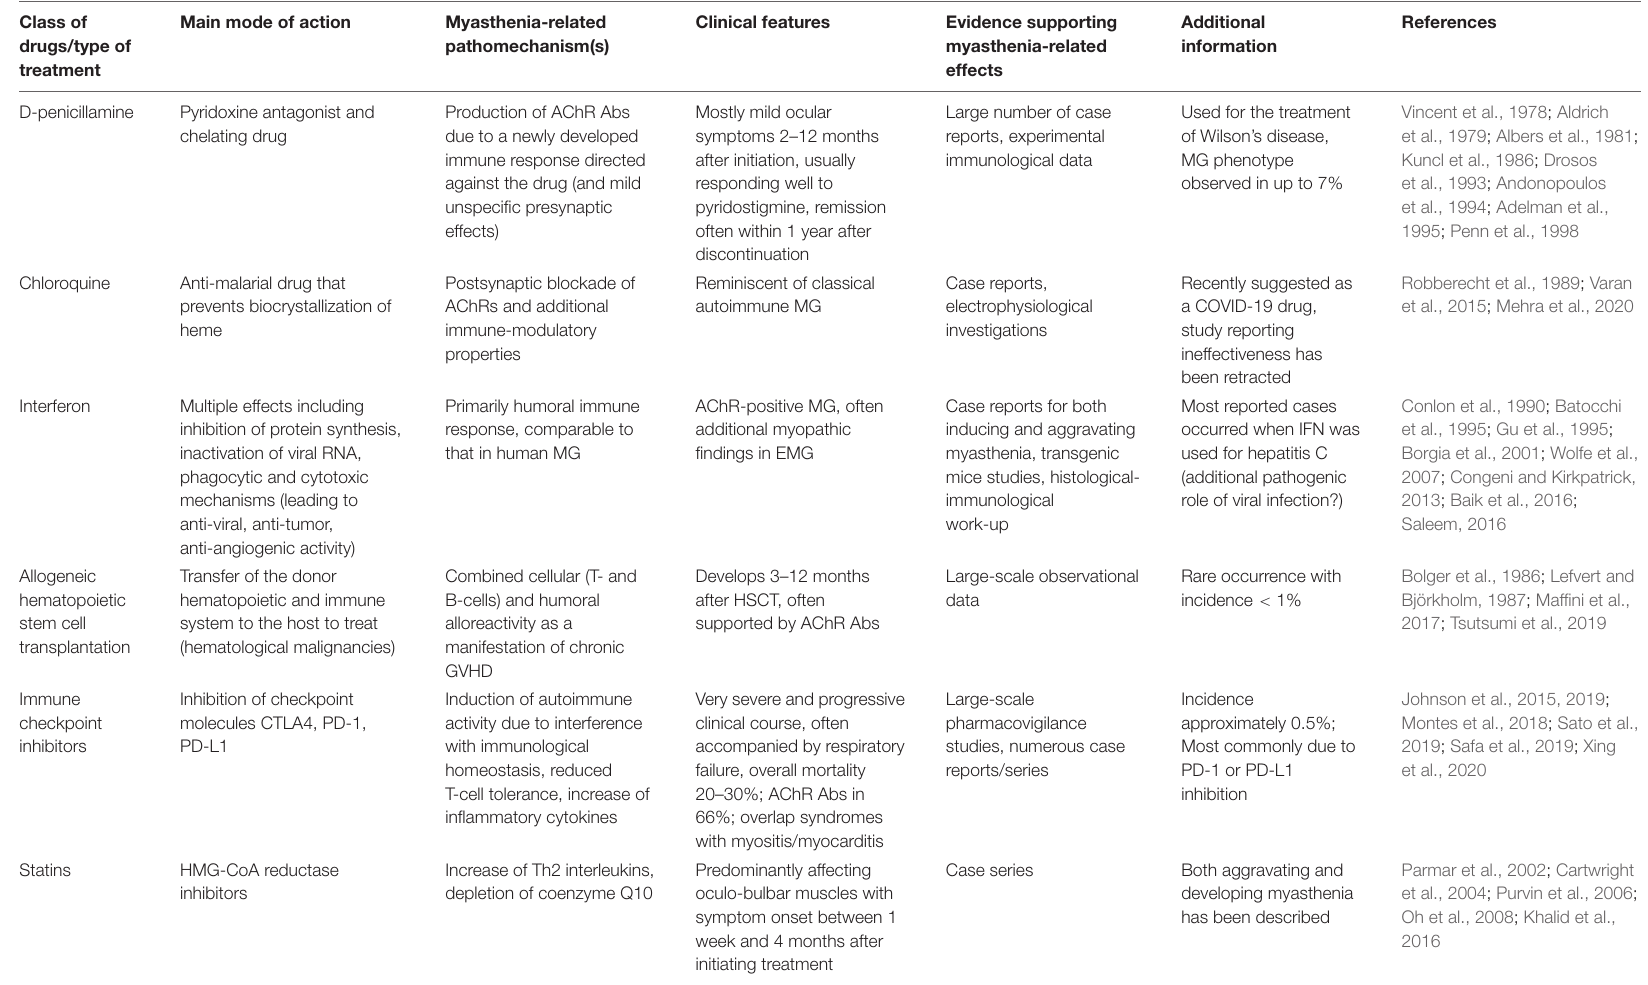
TABLE 2 | Drugs and medical treatments with best evidence for an association with the development of de novo myasthenic syndromes. Class of drugs/type